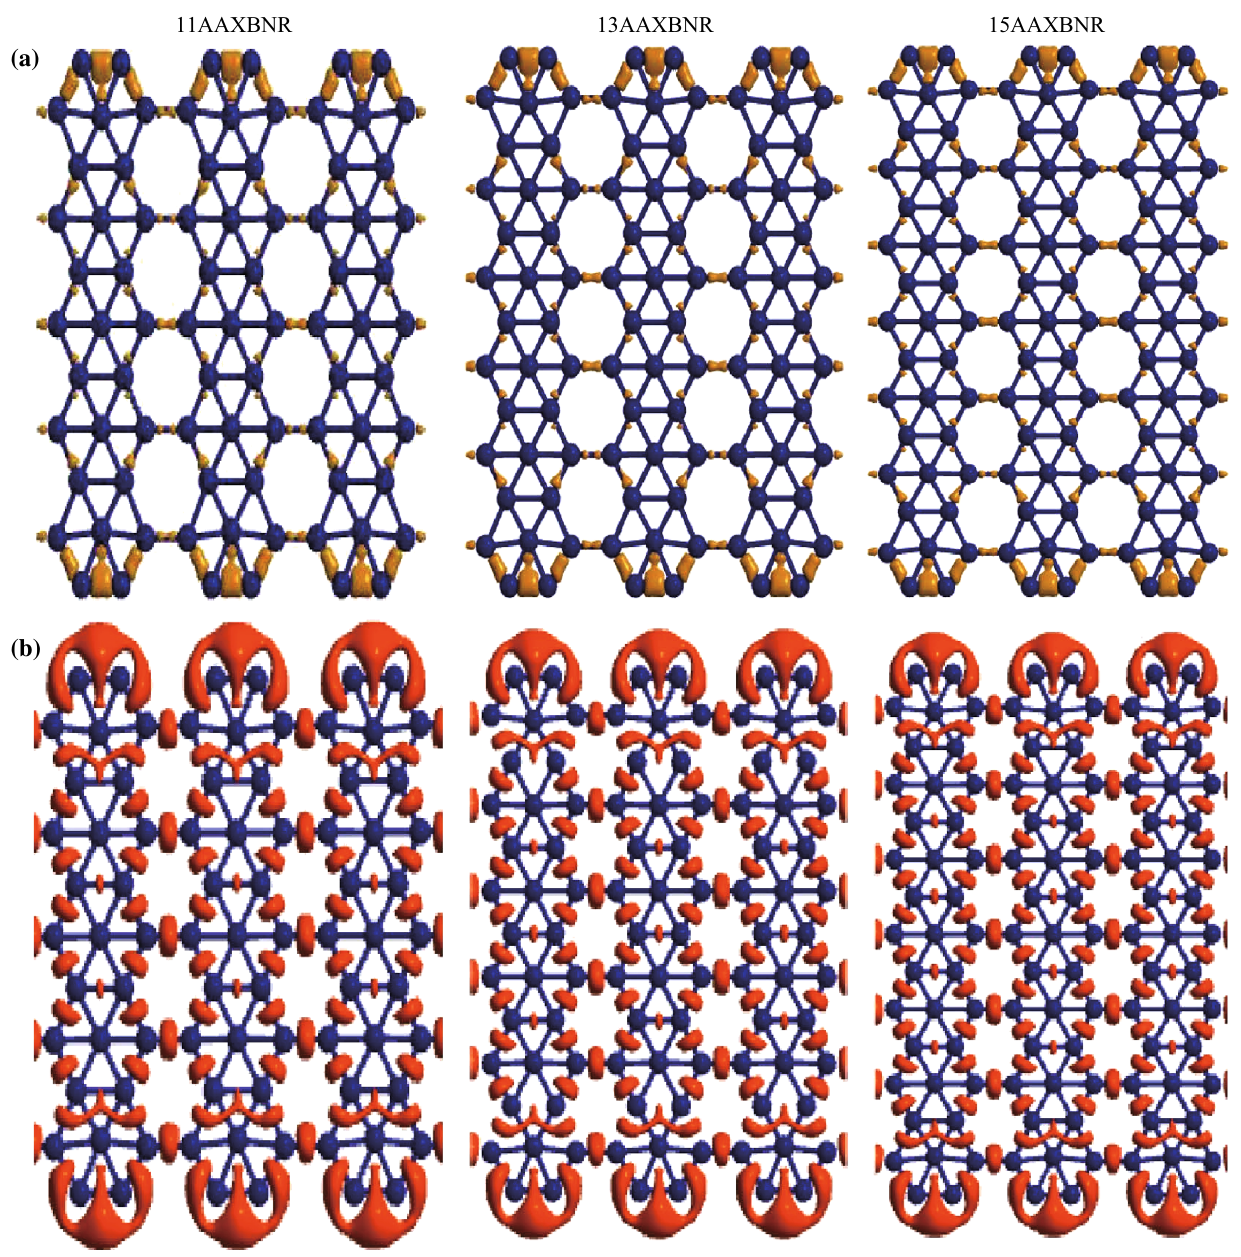
Fig. 3 a The electron density and b the electron localized function (ELF) of 11AAXBNR , 13AAXBNR , and